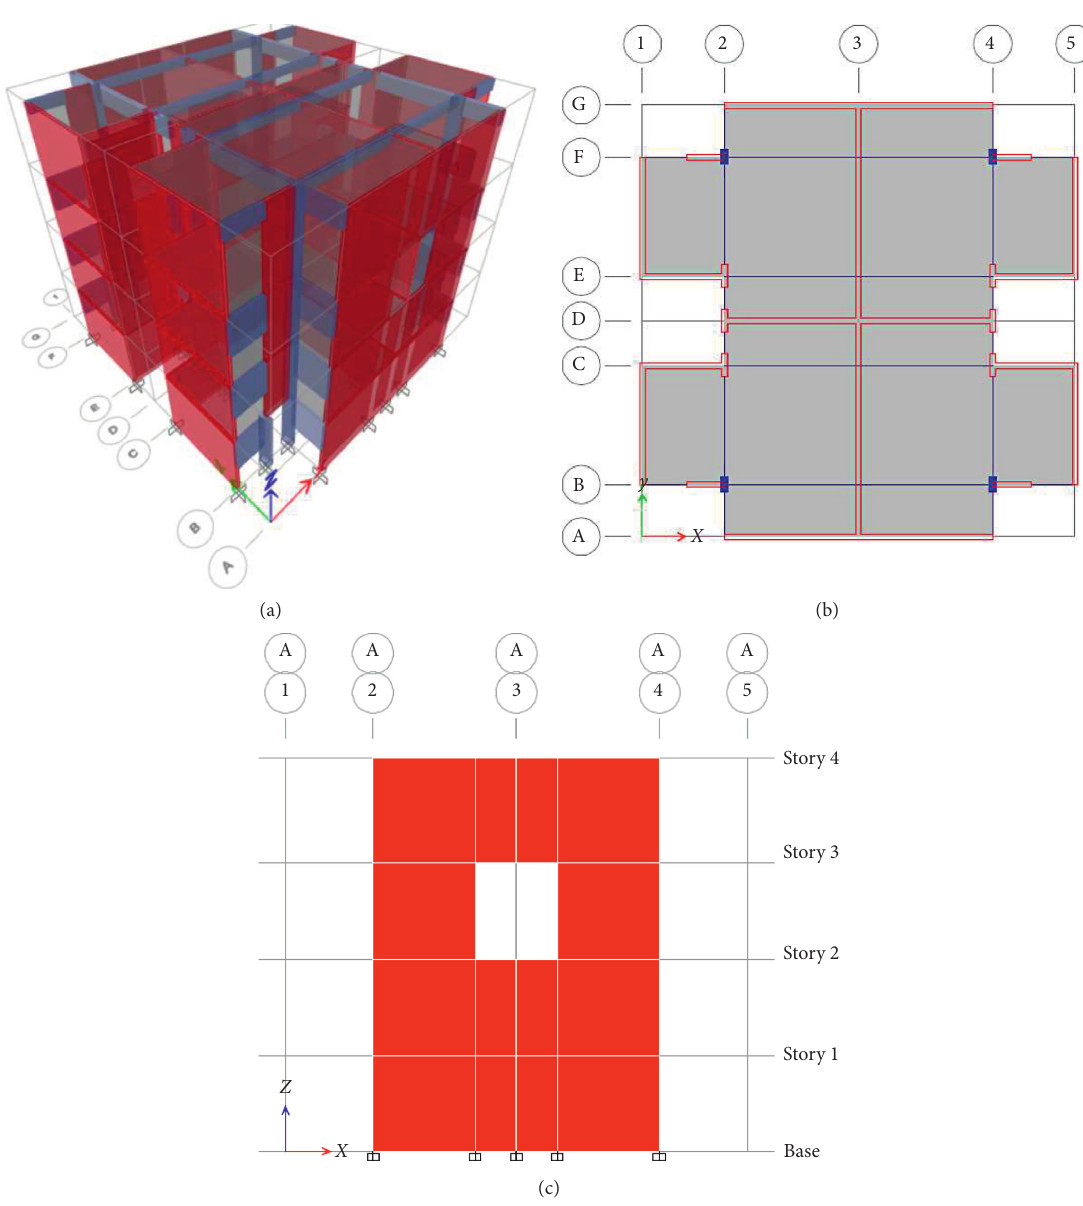
Figure 3: Discretized FB element model for RC shear